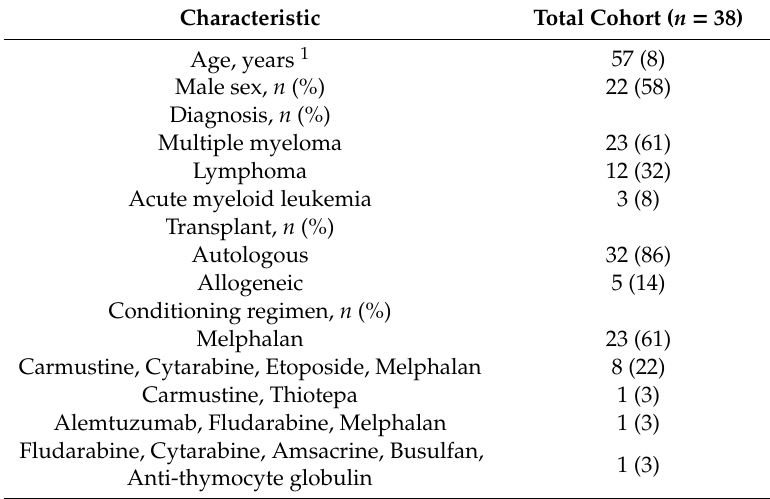
Table 1. Participant characteristics.